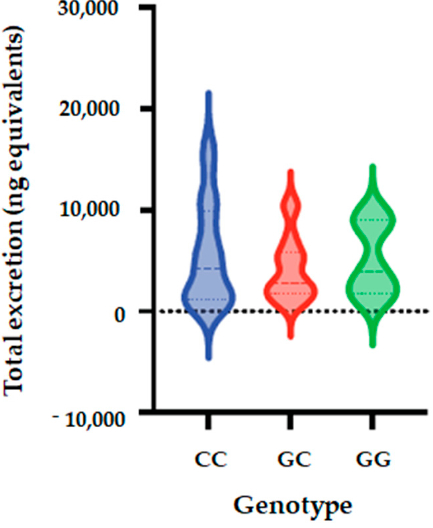
Figure 4. Total metabolite concentrations in urine depending on genotypes of SULT1C4_rs1402467 polymorphism. Bars in the box show the first quartile, the third quartile, and median and whisker charts represent the minimum to maximum values.